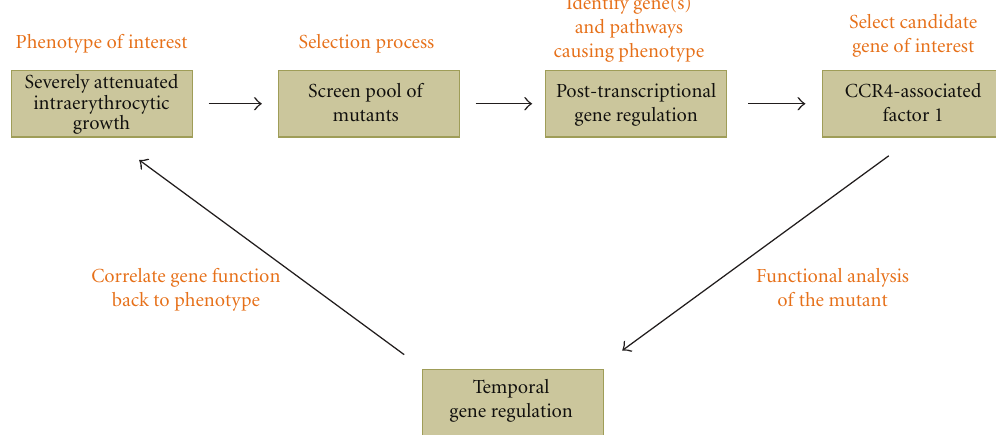
Figure 3: An example of a successful forward genetic approach in P. falciparum . A screen for attenuated intraerythrocytic growth indicates the significance of post-transcriptional gene regulation in these stages. Functional characterization of CCR4-Associated Factor 1 has revealed a role in temporal regulation of gene expression in P. falciparum , implying its importance in intraerythrocytic development.